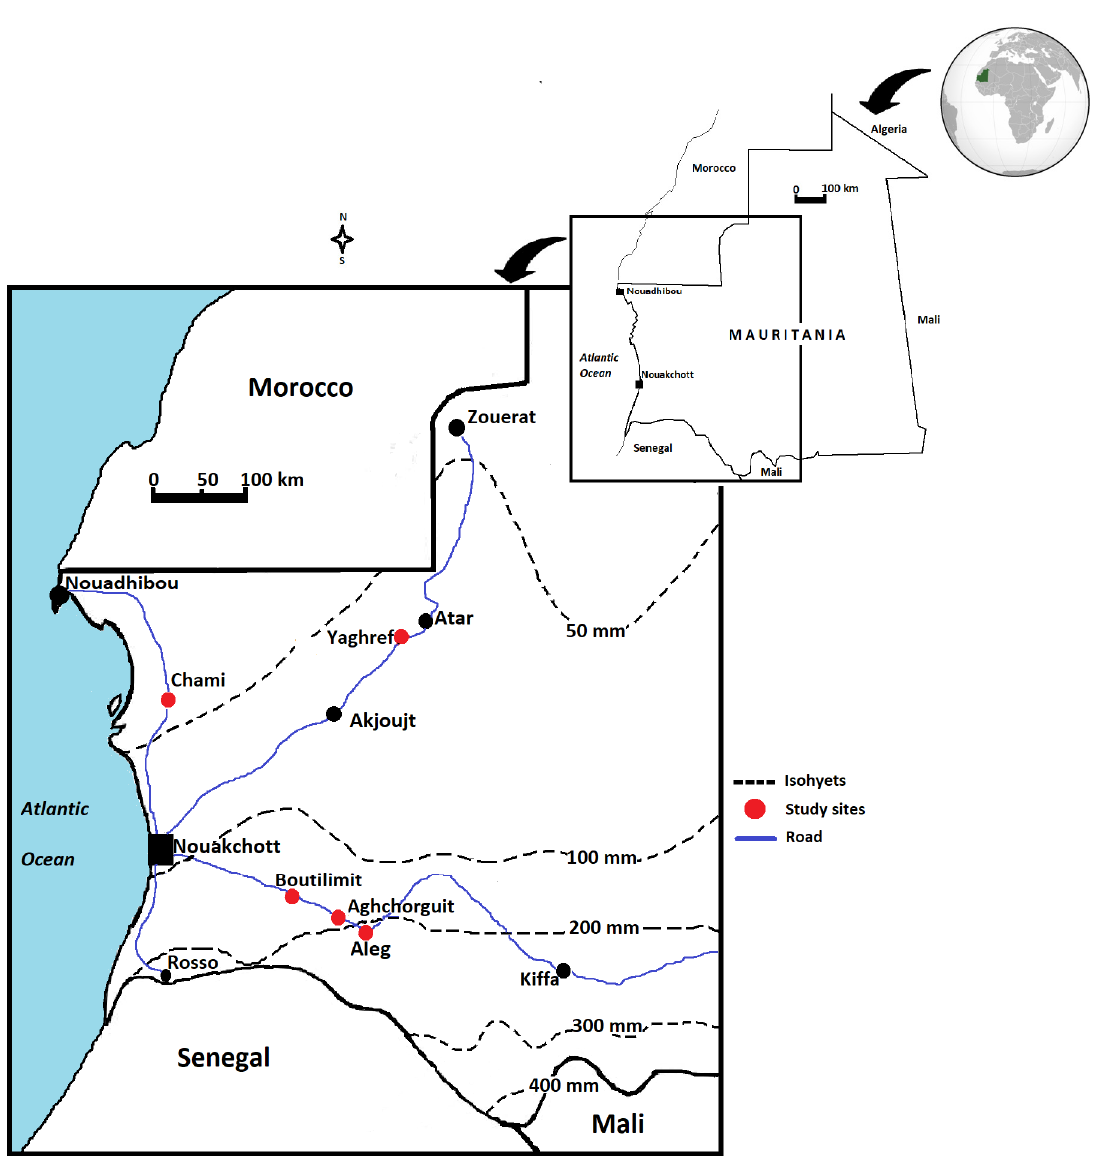
Figure 2. Distribution map of the five locations of Balanites aegyptiaca trees in the central arid (Aleg, Aghchorguit and Boutilimit) and northern hyper-arid (Yaghref and Chami) zones in Mauritania, Northwest Africa. Professor Ali Ould Mohamed Salem Boukhary created Figure 2 by using the Microsoft Paint application.